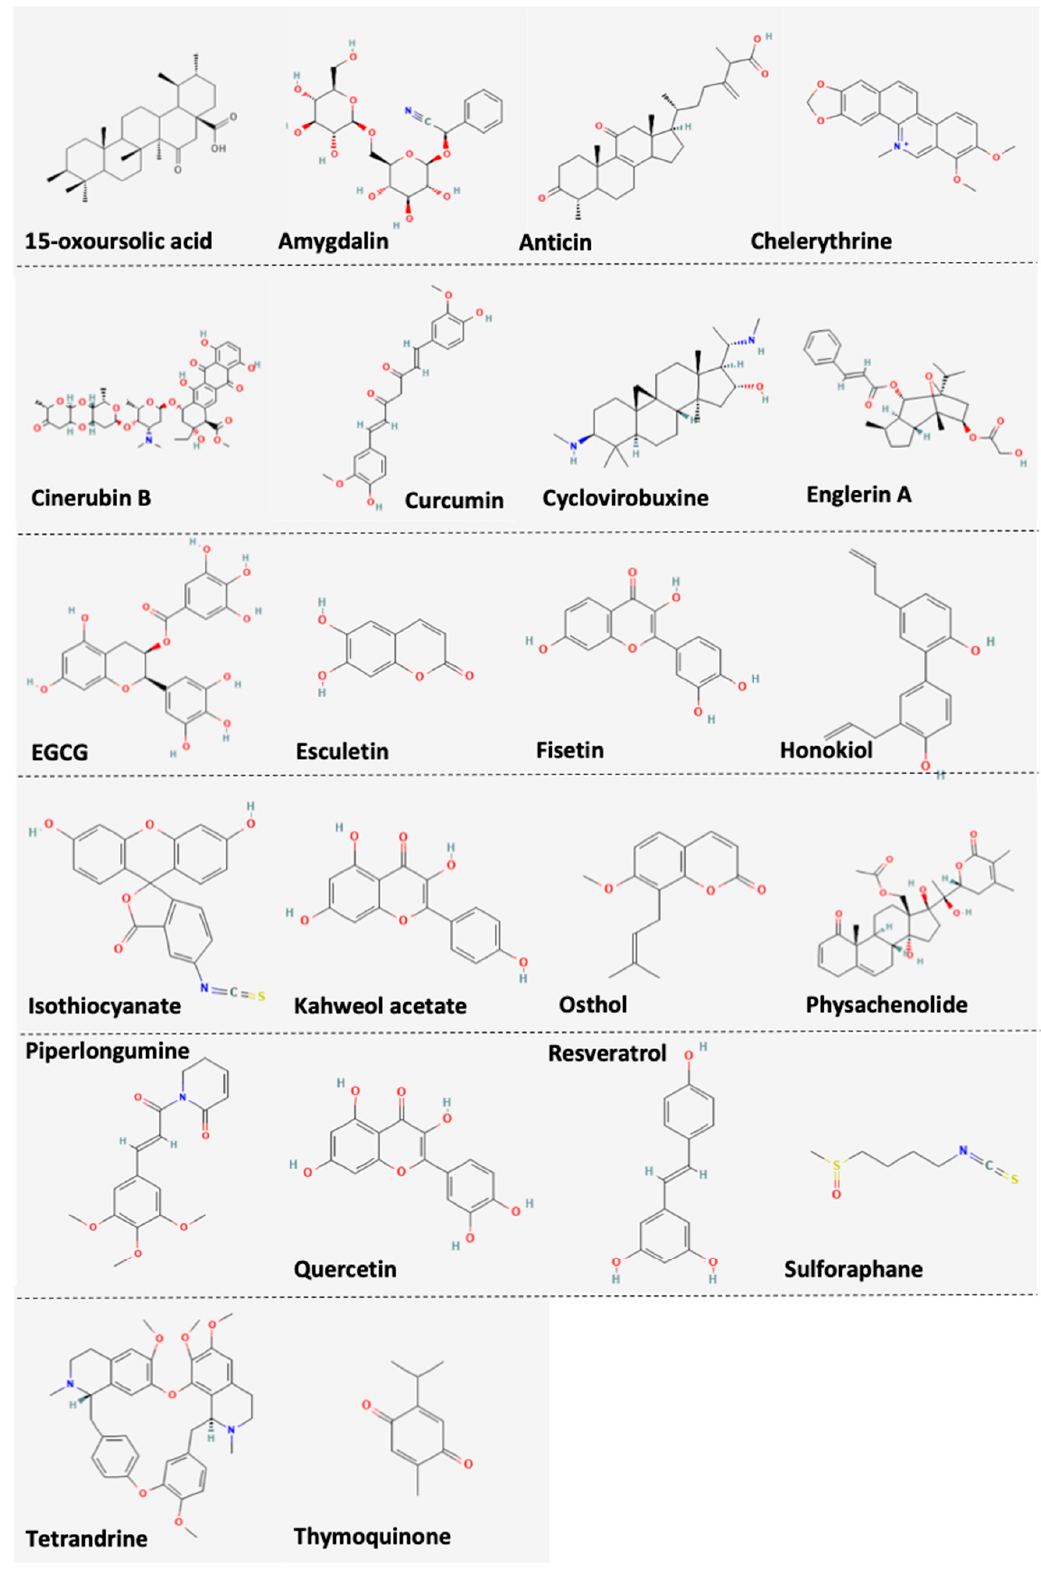
Figure 1. Chemical structures of compounds listed in the current review.